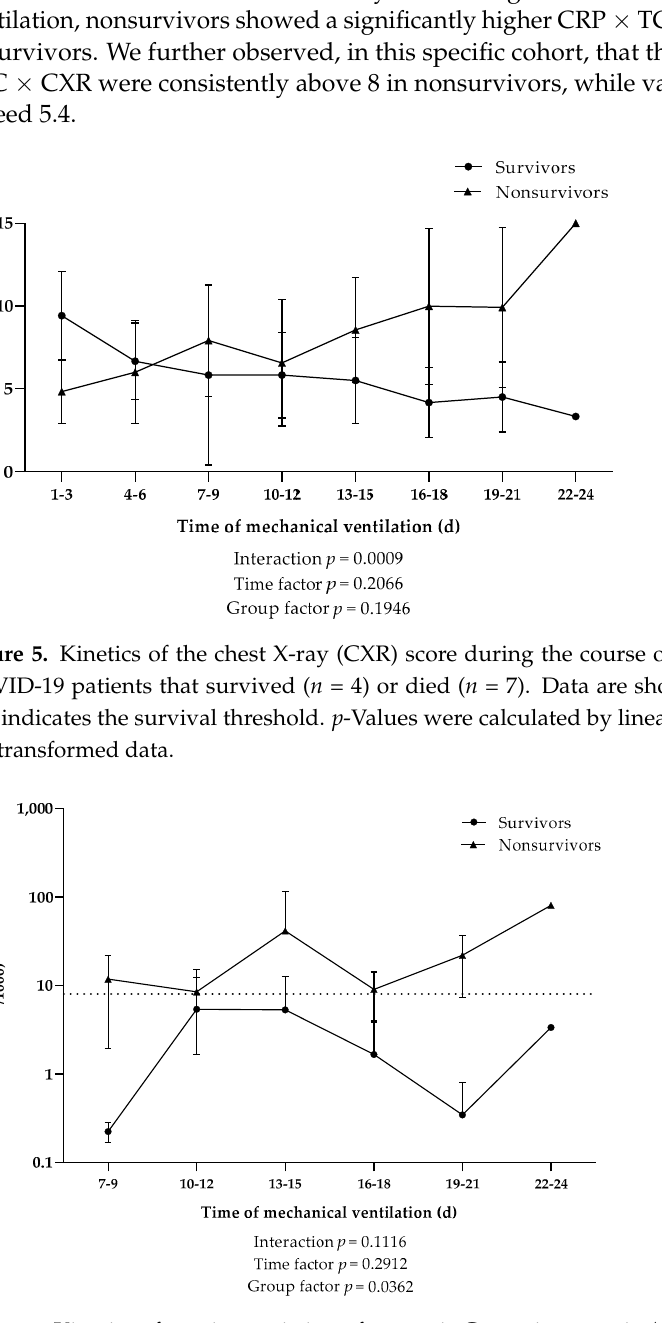
Figure 6. Kinetics of a ratio consisting of systemic C-reactive protein (CRP), terminal complement